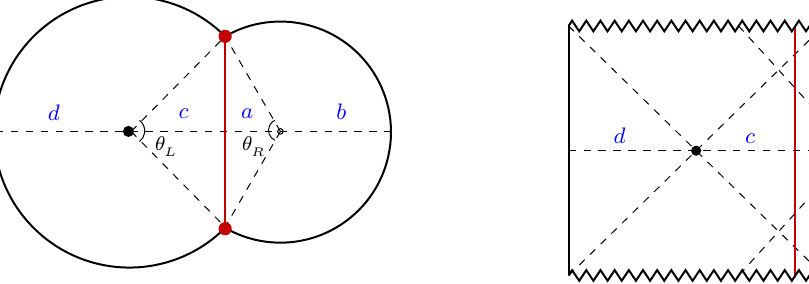
Figure 2 . The euclidean and lorentzian space-time dual to the partially entangled states (1.7). The worldline of the massive bulk particle created by the operator insertion O ‘ is indicated by the red line. It divides the space-time into two AdS 2 regions. For a su(cid:14)ciently massive particle, the worldline is hidden behind two horizons. In this (cid:12)gure, the left-horizon is the true ‘extremal surface’ with minimal value (cid:8) of the L